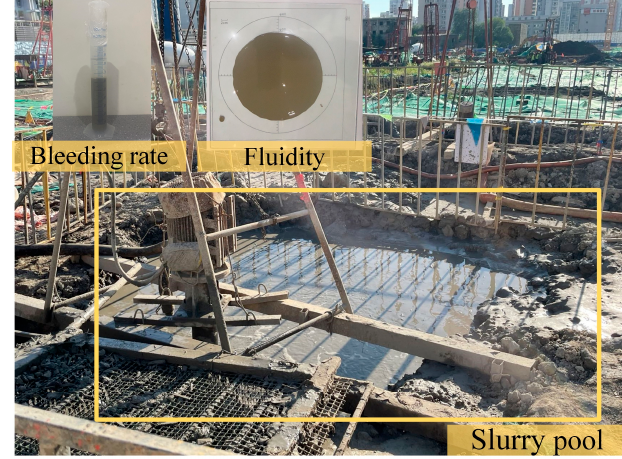
Figure 1. DWS from bored pile in the slurry pool.